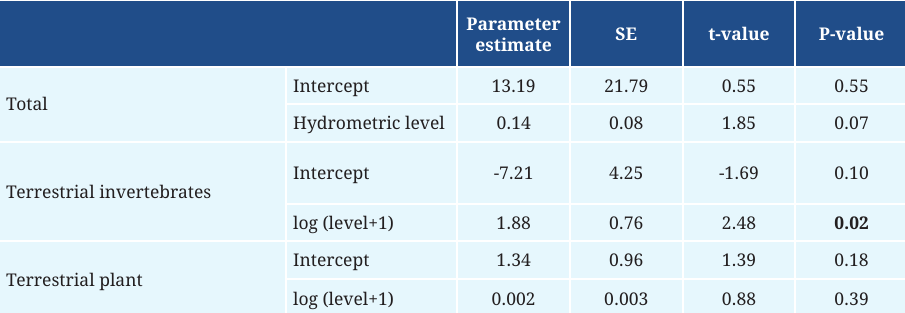
TABLE 1 | Results of generalized linear mixed model analysis between the consumption of allochthonous items by Trachelyopterus galeatus in function of the hydrometric level of the floodplain. P-values < 0.05 are in bold. SE = Standard